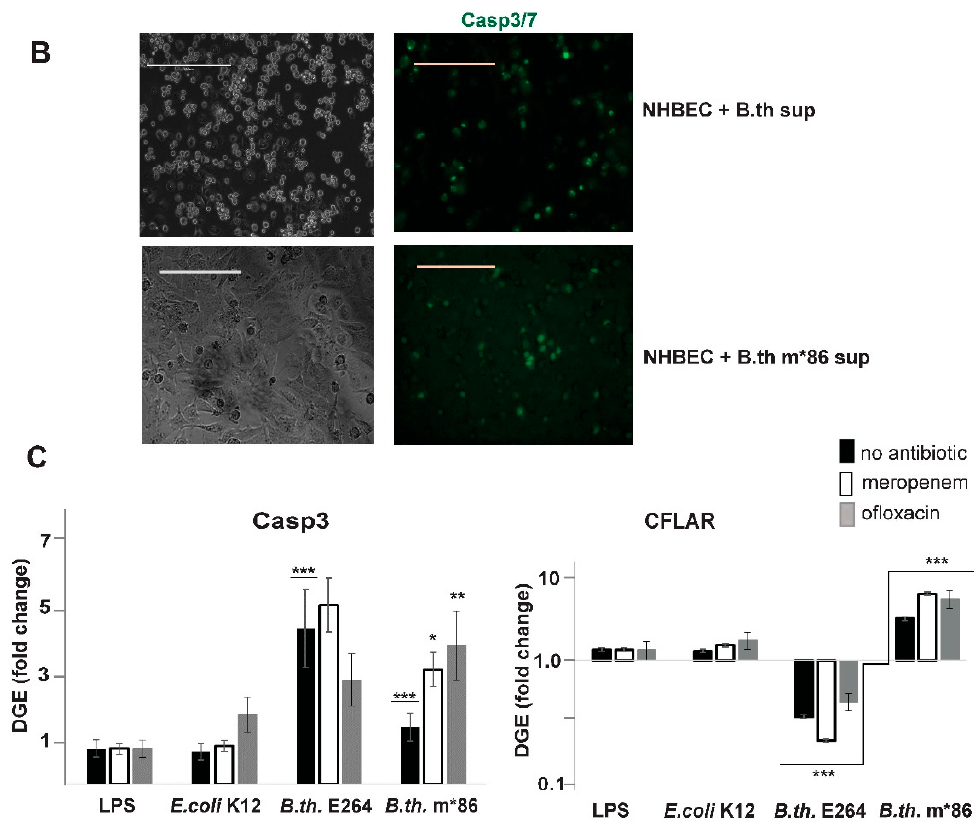
Figure 5. The natural product of PKS (BTH_RS24270) function in B. thailandensis (burkholdac) inhibits histone deacetylase (HDAC) function and CFLAR-regulated pro-survival mechanism in host peripheral mononuclear blood cells (PBMC). ( A ) ELISA specific to acetylated histone 3 was performed on nuclear extracts from PBMC exposed for 24 h to conditioned media from naïve or antibiotic-treated B. pseudomallei ∆ 82 ( B.p . 82), B. thailandensis E264 ( B.th. E264), PKS mutant B.th. #8684 strain (B.th. *m86), and P. aeruginosa ( P.a .). The absorbance at OD450 was normalized to total input protein per sample. Trichostatin A (TSA) treatment (100 ng/mL) was used as a positive control for HDACi function. The mean and standard deviations were obtained from four technical replicas of a representative of three independent PBMC exposure experiments; ( B ) micrographs of NHBEC after 24 h exposure to filtered conditioned RPMI-10% media from B.th. E264 and B.th . m*86 ( pks mutant) bacterial strains. Brightfield microscopic images of NHBEC were matched with fluorescent images from cells labeled with CellEvent Caspase-3/7 green detection reagent. The white scale bars correspond to 100 µm; ( C ) RT-qPCR analysis of differential gene expression (DGE) in PBMC in response to bacterial conditioned media filtrate. DGE was determined as fold change (2 −ΔΔ C ) relative to mock-treated PBMC. The Ct signals from the Taqman assay for each gene were normalized to GAPDH. Shown are the means and ± standard errors of the means from three independent experiments performed with batch of PBMC exposed to filtrates from three independent B. thailandensis and E. coli K14 growth conditions. Filtrates from RPMI medium supplemented with 10% bovine serum with or without antibiotics (meropenem, Mpm [10 mg/mL], and ofloxacin, Ofl [10 mg/mL]) served as mock treatment controls to filtrates from 24 h bacterial cultures in RPMI- 10% untreated or treated with antibiotics. Purified LPS from E. coli was added at 1 mg/mL to the RPMI media. PKS mutant B. thailandensis #8684 strain ( B.th . *m86) was used as control for the burkholdac effect (product of PKS BTH_RS24270) on host cell survival. Statistical significance (* p < 0.05; ** p < 0.01; *** p < 0.001) was determined with an unpaired Student’s t test from the average and standard deviations from four biological